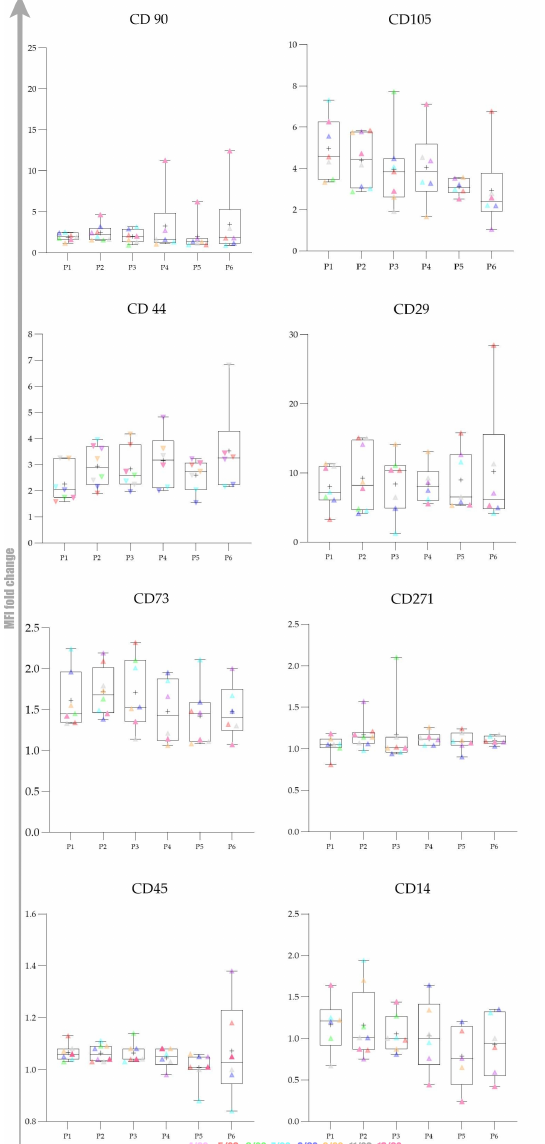
Figure 4. Canine adipose-derived mesenchymal stem cells (cAD-MSCs) surface markers expression pattern during in vitro cultivation. cAD-MSCs. The expression pattern was analysed by calculation of fold change of median fluorescence intensity (MFI). The results are based on eight biological replicates, young female canines referred to as elective surgery procedures with no obvious signs of disease. Flow cytometry assessment of positive and negative cAD-MSCs markers showed no statistically significant changes in the expression of the following positive markers: CD90, CD44, CD29, CD105 and CD271. A statistically significant change in expression was observed for CD73 between early (P1–P3) and late (P4–P6) passages. The X -axis represents the passage number (from P1 to P6), whereas the Y -axis displays the average fold change of MFI. MFI fold change was calculated by dividing the median of the appropriate antibody with the median of isotype control. The Whisker box plot was created to present the dynamics of changes between passages. Centerlines denote the median, plus the mean, box limits indicate the twenty-fifth and seventy-fifth percentiles; whiskers represent the maximum and minimum of the acquired values. Individual values are shown in colours to reveal changes for each donor included in the study. Donor 4/20 is presented in light pink, 5/20 in red, 6/20 in green, 7/20 in light blue, 8/20 in purple, 9/20 in orange, 11/20 in grey and 13/20 in dark